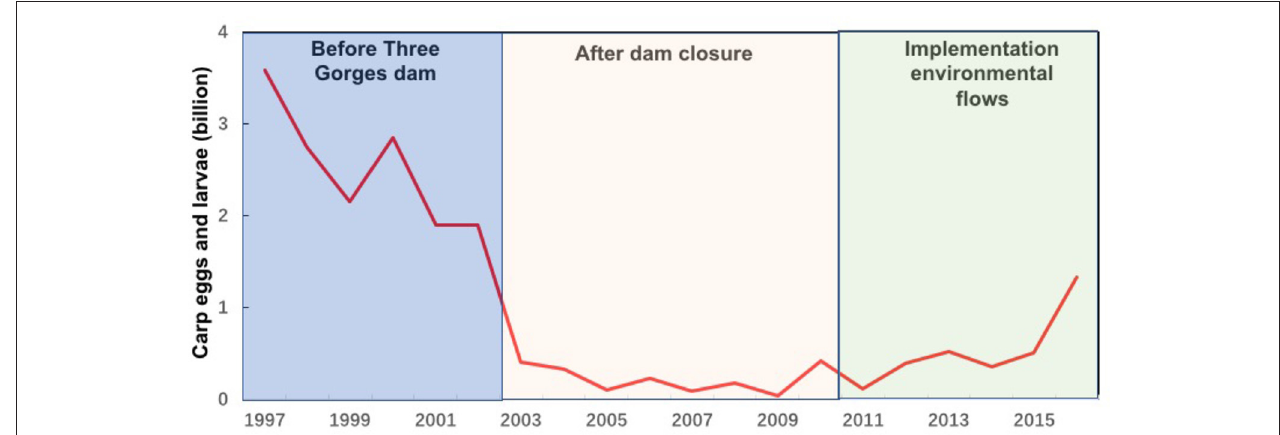
FIGURE 2 | Annual results of monitoring of carp egg and larvae in the Yangtze downstream of Three Gorges Dam during three periods: before the dam, after dam closure, and during the period of environmental flow operation.